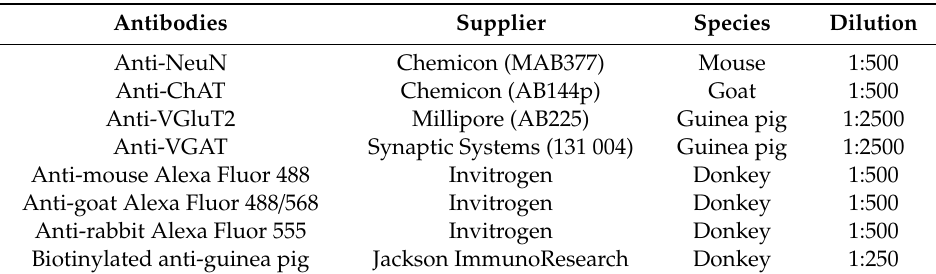
Table 1. List of